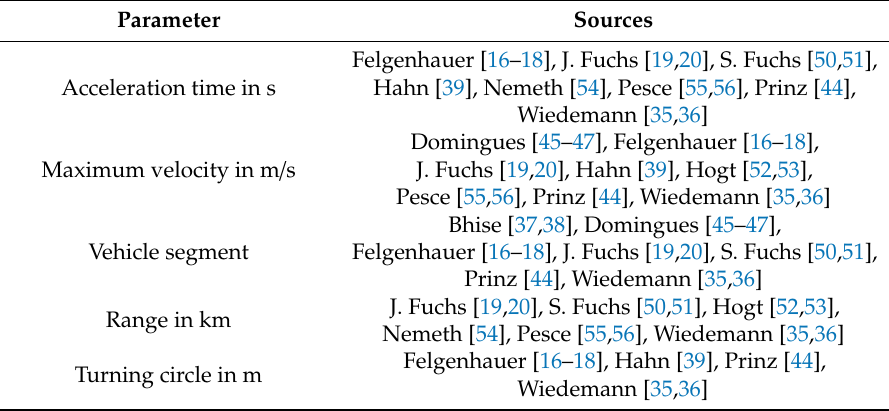
Table 8. Overview of the design parameters for the vehicle